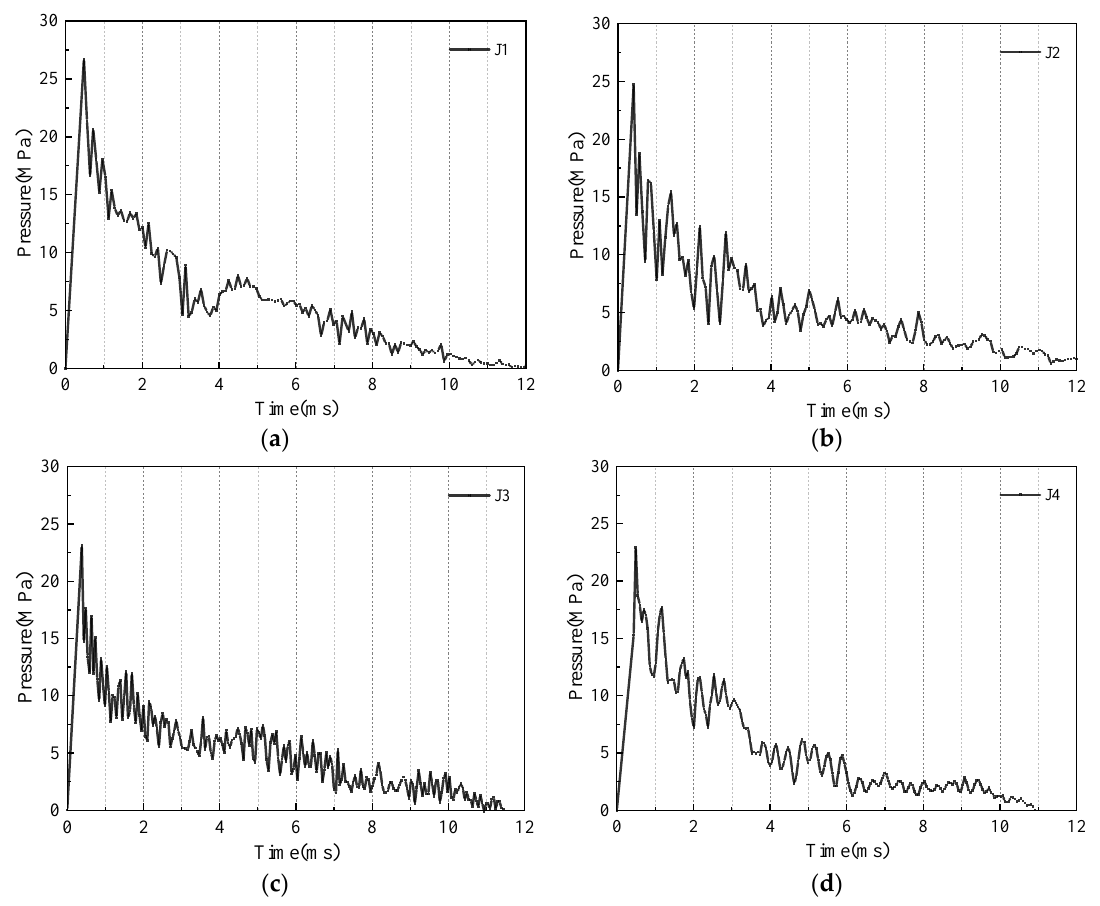
Figure 7. The measured pressure time travel curves at the bottom of the explosion cavity: ( a ) measuring point J1; ( b ) measuring point J2; ( c ) measuring point J3; ( d ) measuring point J4. Table 5. The measured results at the bottom of the explosion cavity.